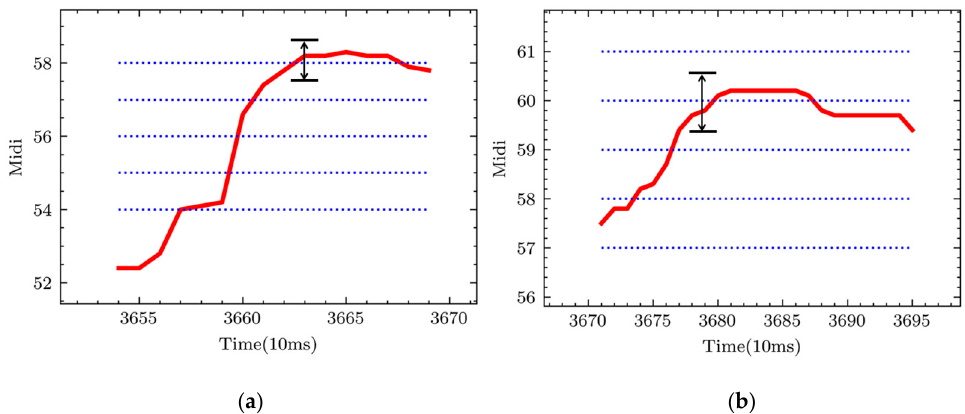
Figure 8. Using pitch line matching to obtain a pitch for each note. The red line is a note, the blue dashed lines are the pitch line, and the black arrow is the matching range (±50 cents); ( a , b ) are the fragment of the dataset “Cmedia”.